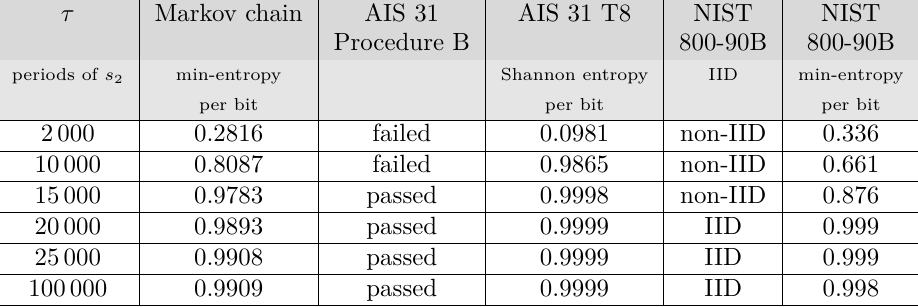
Table 8: Entropy estimation using high order Markov chains, AIS 31 and NIST 800-90B tests, when two internal ROs and the least significant bits of the first differences of counter values were used. Dependencies are modeled using 8 th order Markov